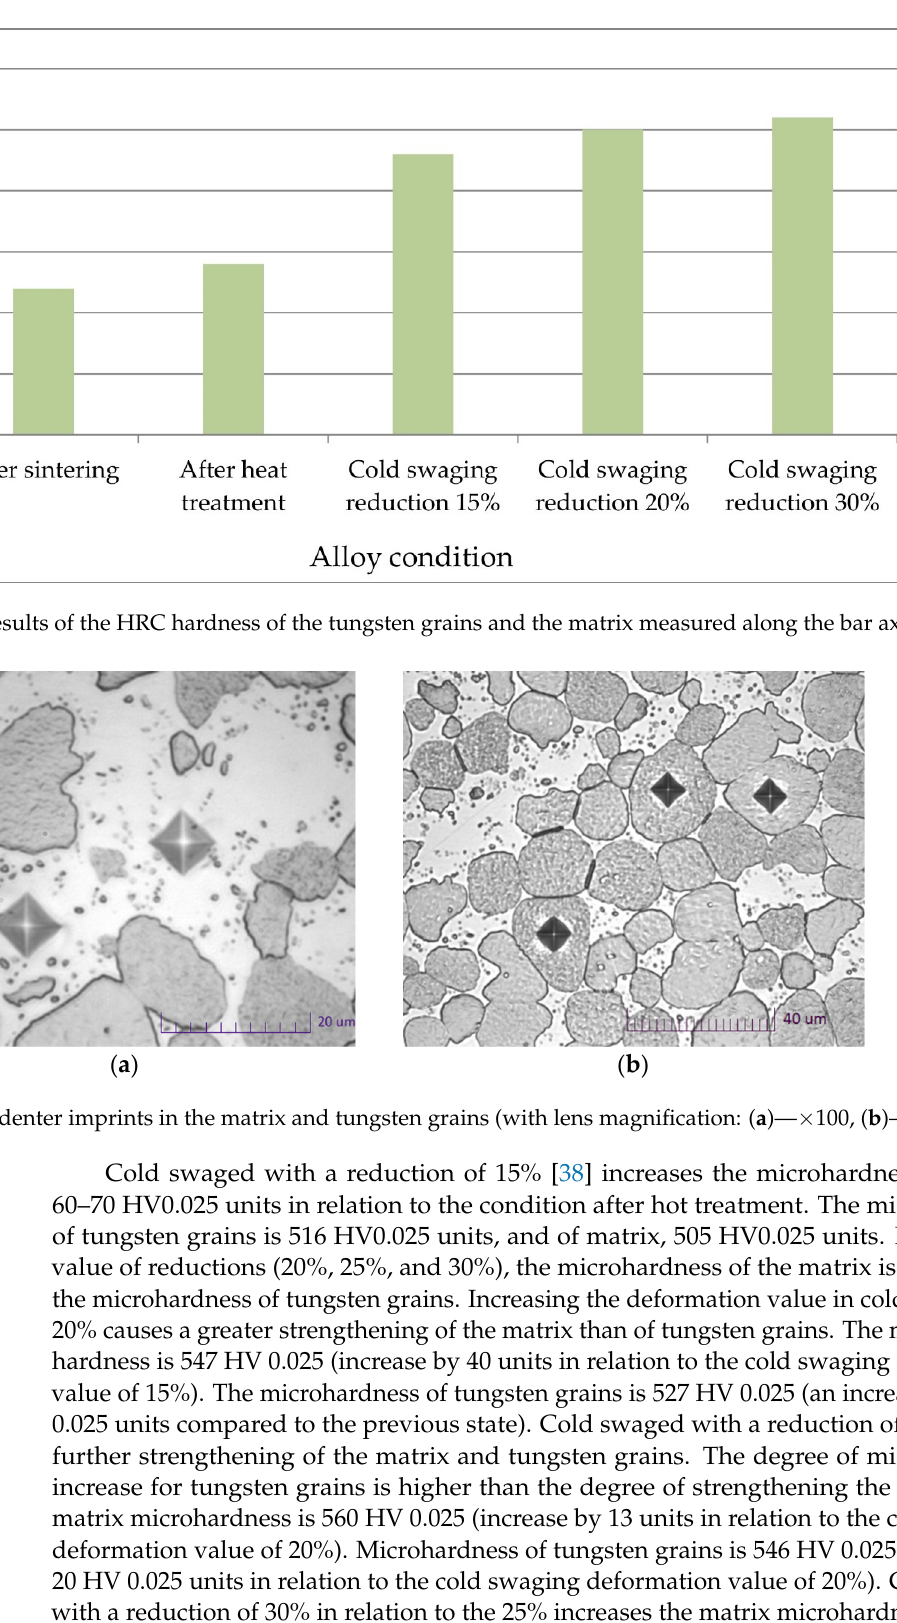
Materials 2021 , 14 , x FOR PEER REVIEW 10 of 14 microhardness is 547 HV 0.025 (increase by 40 units in relation to the cold swaging de- formation value of 15%). The microhardness of tungsten grains is 527 HV 0.025 (an in- crease of 10 HV 0.025 units compared to the previous state). Cold swaged with a reduc- tion of 25% causes further strengthening of the matrix and tungsten grains. The degree of microhardness increase for tungsten grains is higher than the degree of strengthening the matrix. The matrix microhardness is 560 HV 0.025 (increase by 13 units in relation to the cold swaging deformation value of 20%). Microhardness of tungsten grains is 546 HV 0.025 (increase by 20 HV 0.025 units in relation to the cold swaging deformation value of